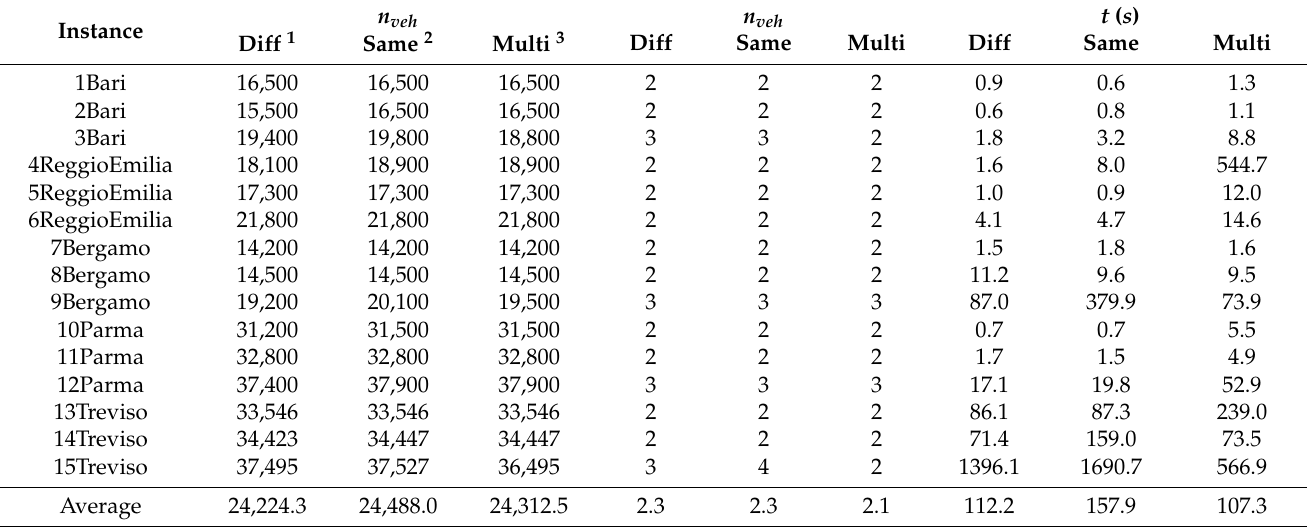
Table 11. Comparison results for three scenarios.